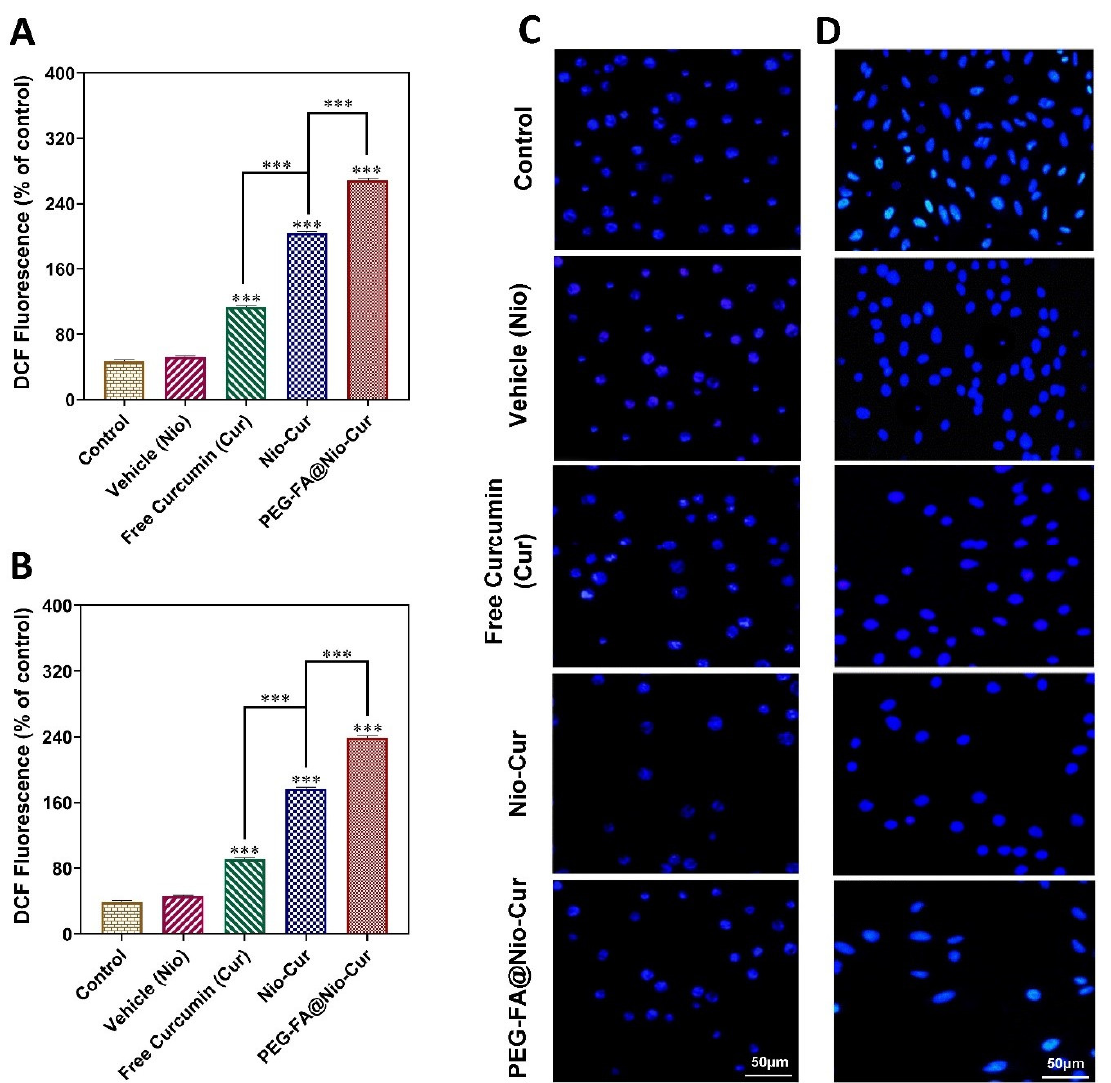
Figure 7. ( A , B ) Changes in intracellular ROS content, indicated by the fluorescence of 2′, 7′-dichlorodihydrofluorescein (DCF), are summarized in ( A ) for MCF7 cells and ( B ) for 4T1 cells; ( C , D ) DAPI staining of vehicle (Nio), Cur, Nio-Cur, and PEG-FA@Nio-Cur on ( C ) MCF7 and ( D ) Fluorescence in 4T1 is brighter than in normal nuclei because of the apoptotic condition of compacted chromatin (control). Data represent means ± standard deviations ( n = 3). For all charts, ***: p < 0.001; **: p < 0.01; *: p < 0.05.